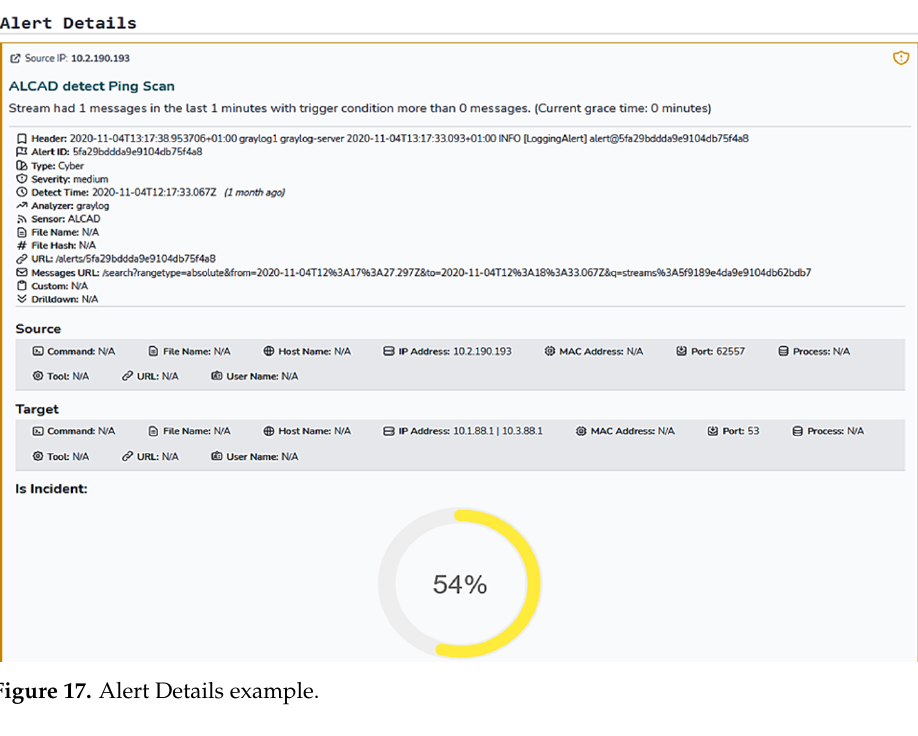
Figure 17. Alert Details example.